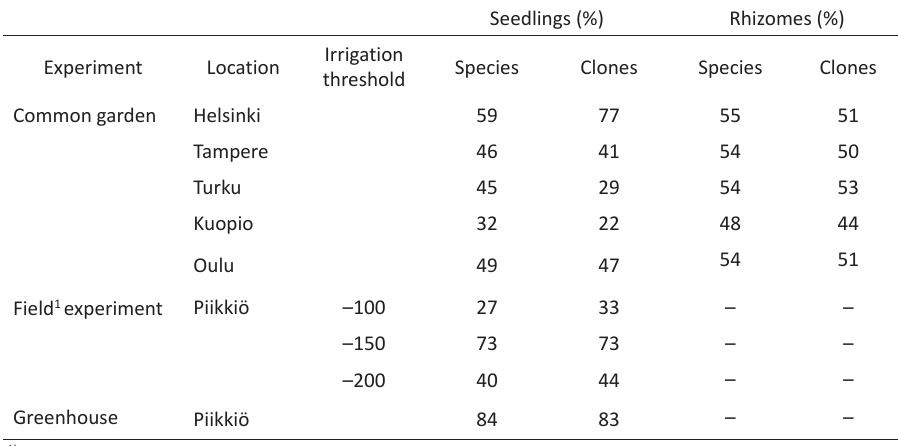
Table 2. Percentage of species and clones that were found to produce seedlings and rhizomes in common gardens and moisture controlled field experiment. In greenhouse experiment percentage of species and clones that emerged during 221 days after